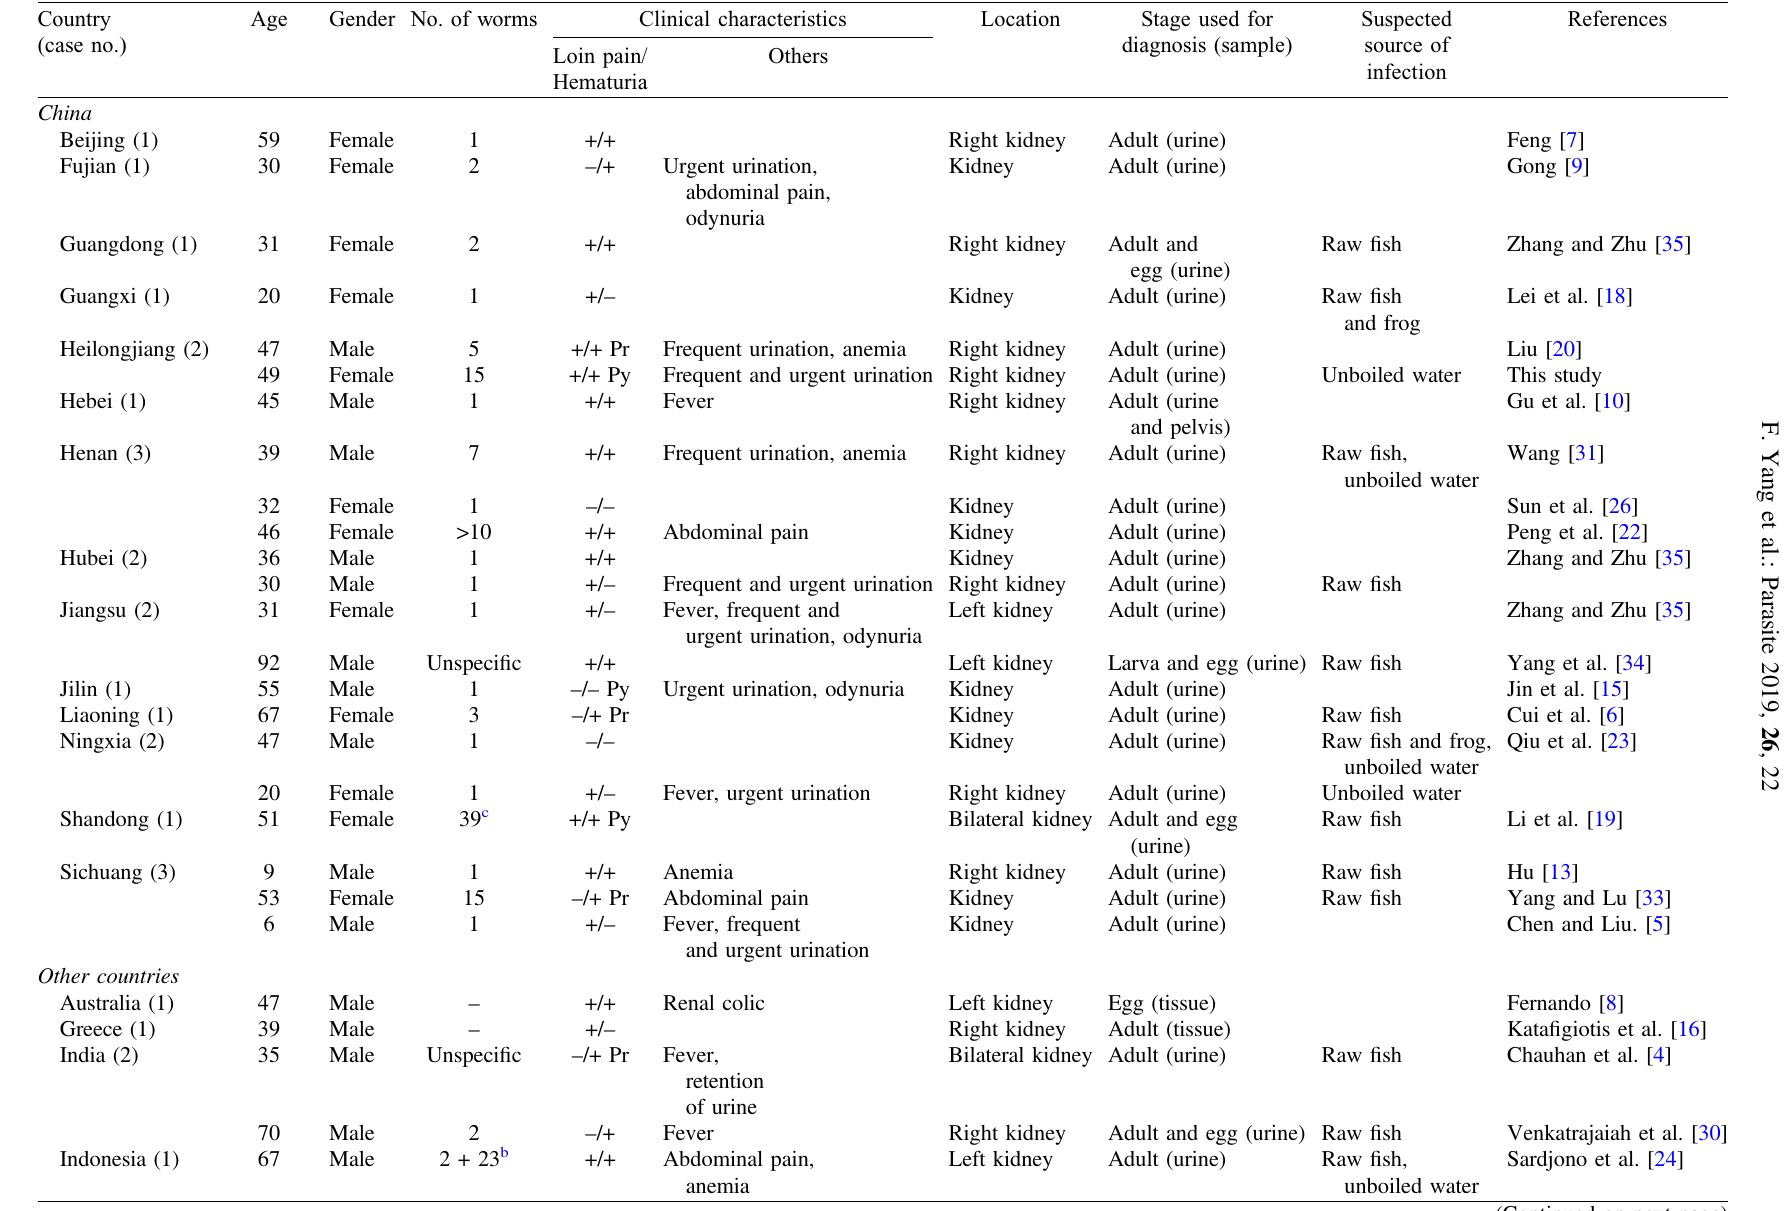
Table 1. Human cases of Dioctophyma renale worldwide published in PubMed and Chinese databases.